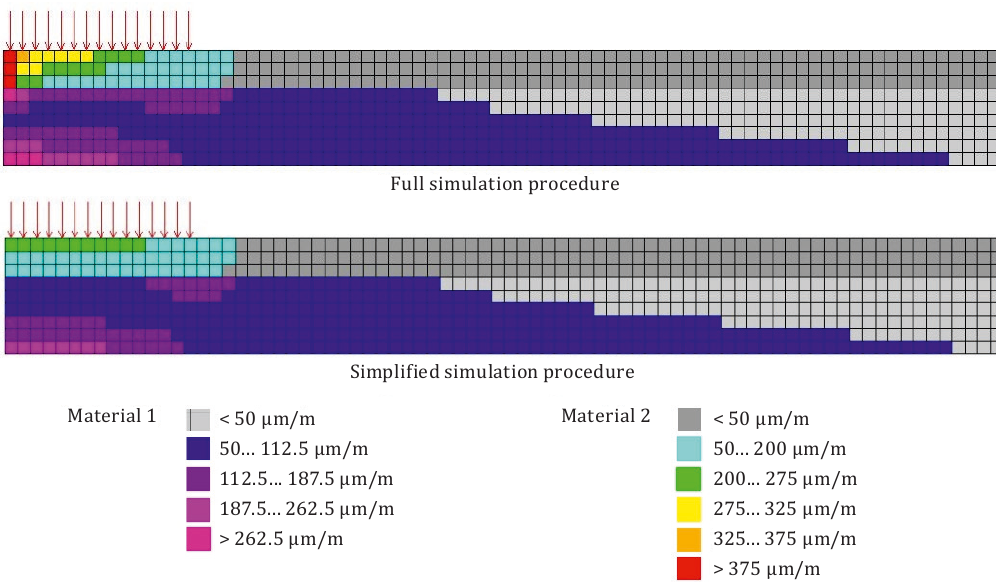
Figure 10. Distribution of fatigue models after 6 000 000 loading